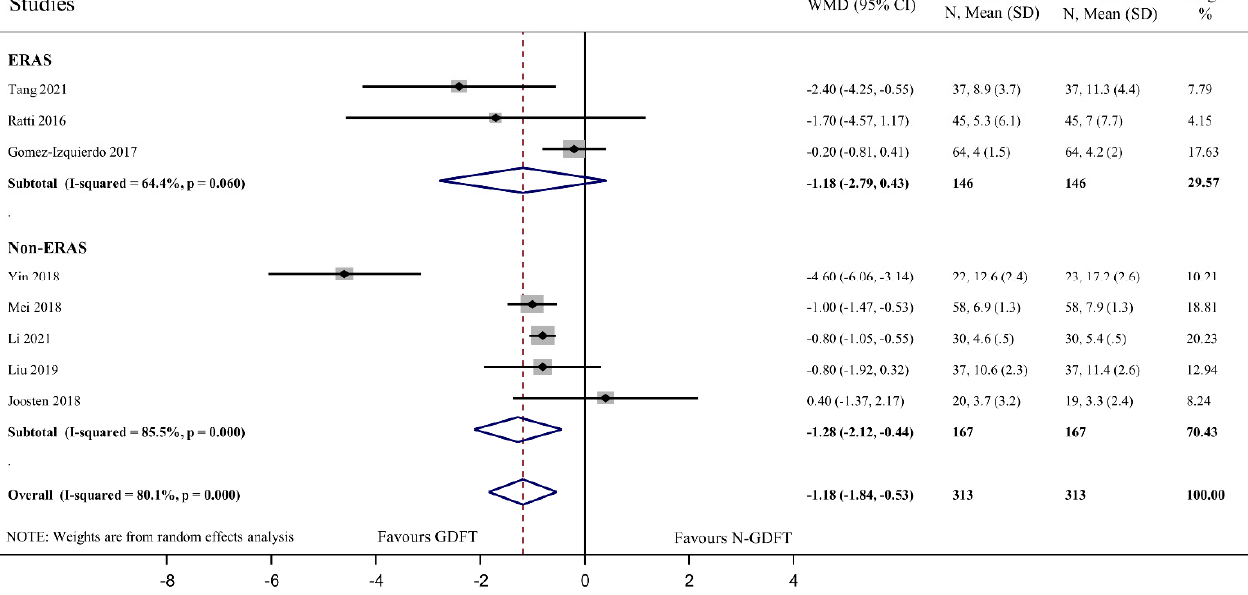
Figure 2. Length of hospital stay (days). Length of hospital stay was significantly shorter in patients who received GDFT (WMD = − 1.18 days; 95% CI = − 1.84 days to − 0.53 days) and also in the non-ERAS subgroup (WMD = − 1.28 days; 95% CI = − 2.12 days to − 0.44 days). However, in the ERAS subgroup, our result was not significant (WMD = − 1.18 days; 95% CI = − 2.79 days to 0.43 days). Heterogeneity was high both in overall and in the non-ERAS group (I-squared = 80.1%; p < 0.01 and I-squared = 85.5%; p < 0.01), and moderate in the ERAS subgroup (I-squared = 64.4%; p = 0.06).